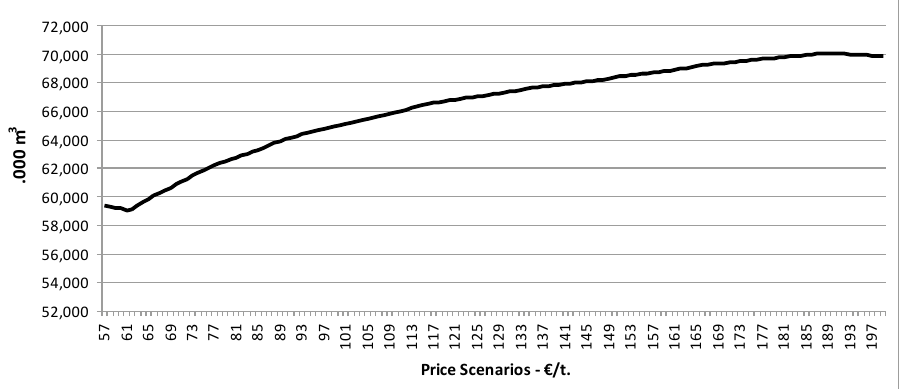
Figure 6. Dynamics in water consumption with sorghum cultivation (province of Parma).